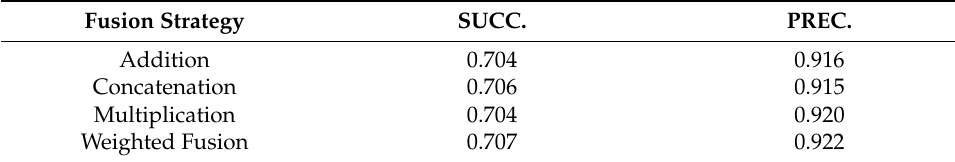
Table 3. Comparative results on NFS. Table 4. Comparison of different feature fusion